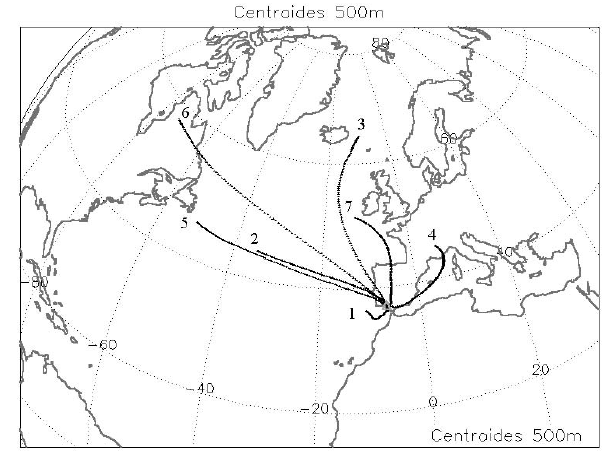
Fig. 8. Centroids of the cluster classification at 500m identified according to the back-trajectory analysis using the HYSPLIT model (Toledano et al.,